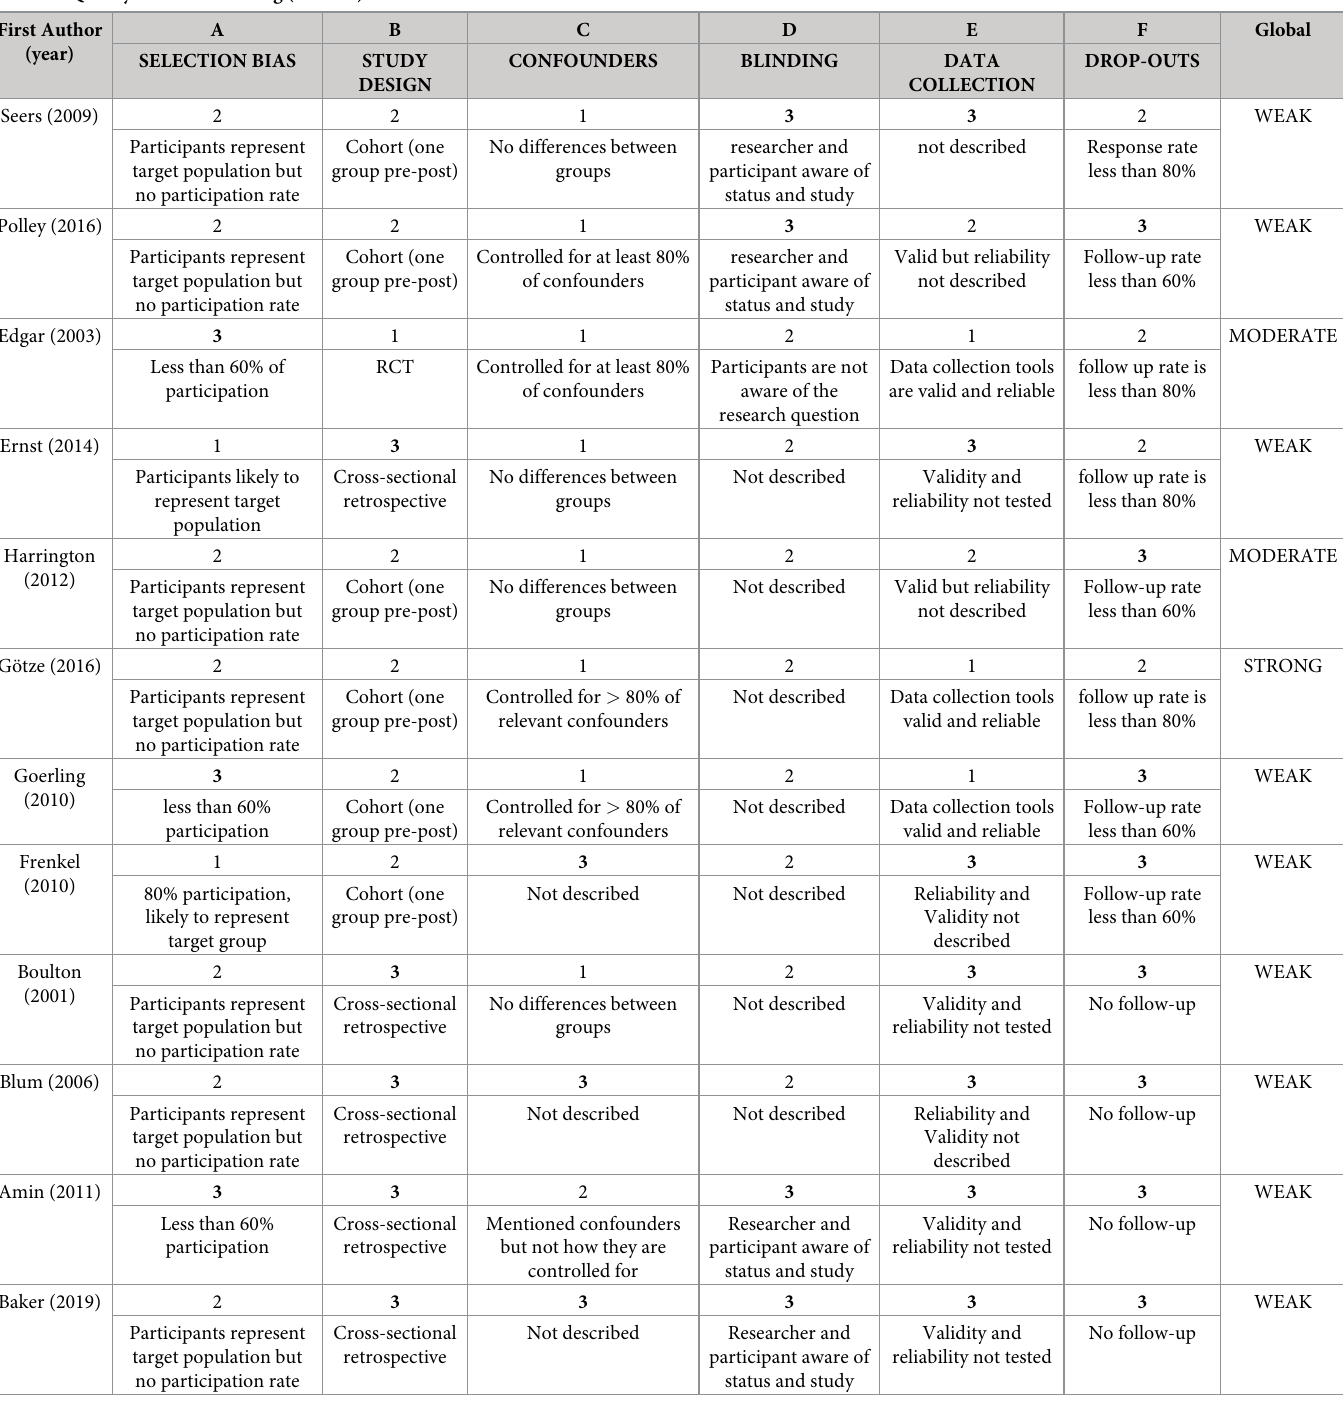
Table 1. Quality assessment rating